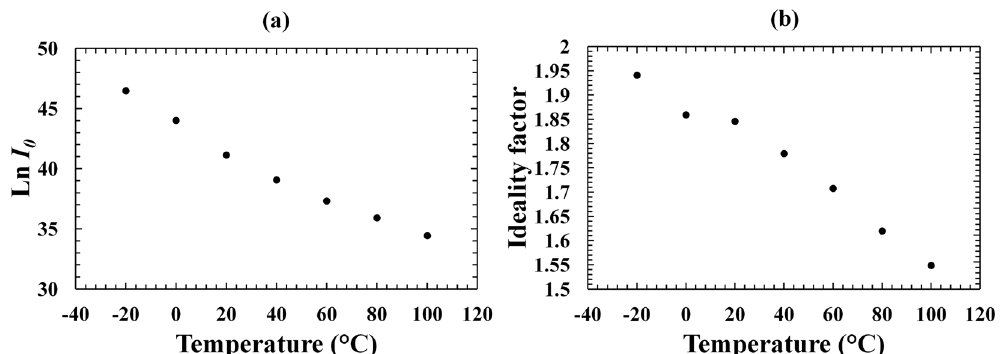
Figure 3. ( a ) The natural logarithm of the saturation current as a function of temperature for the In 0.5 Ga 0.5 P device. ( b ) The ideality factor as a function of temperature for the In 0.5 Ga 0.5 P